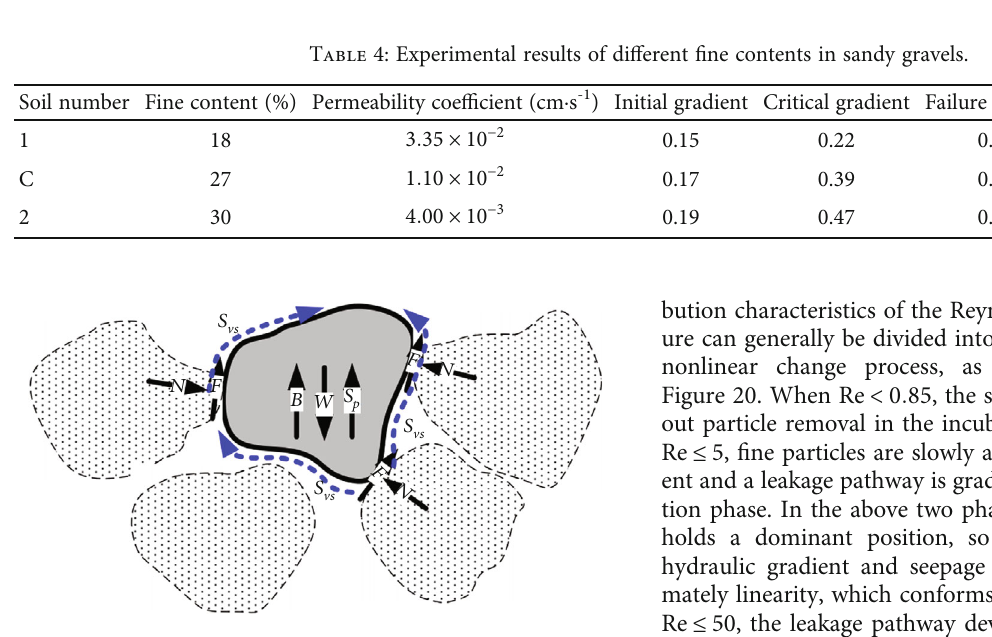
Figure 21: Schematic illustration of various forces acting on a soil particle at the exit face of soil sample (adapted from